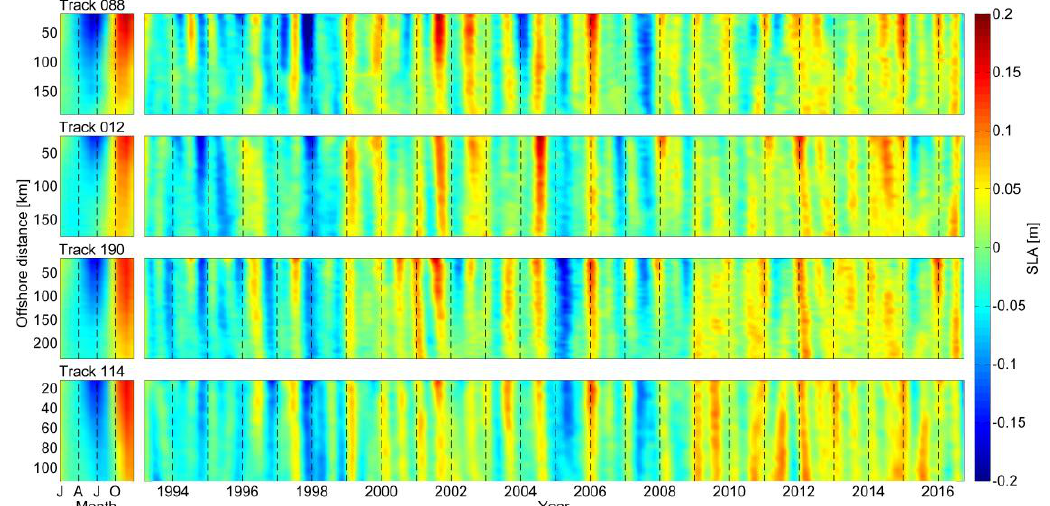
Figure 3. Seasonal cycles (left column) and interannual variabilities (right column) in SLA along four ground tracks within 200 m isobath. Positive or negative values represent above or below the mean sea level, respectively. Track numbers are shown in the upper left corner of left column panels.